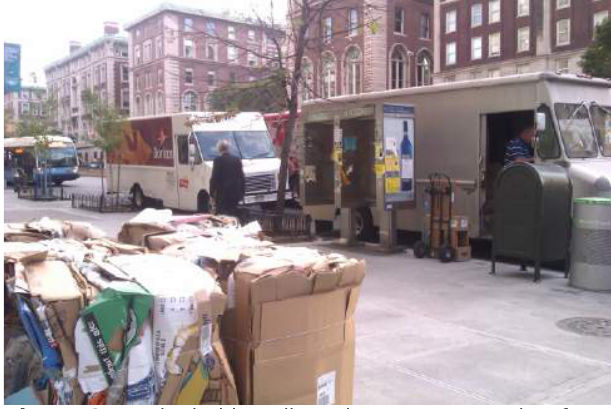
Figure 3. Typical sidewalk and street congestion for food store logistics. 8:00 AM October 5, 2014.